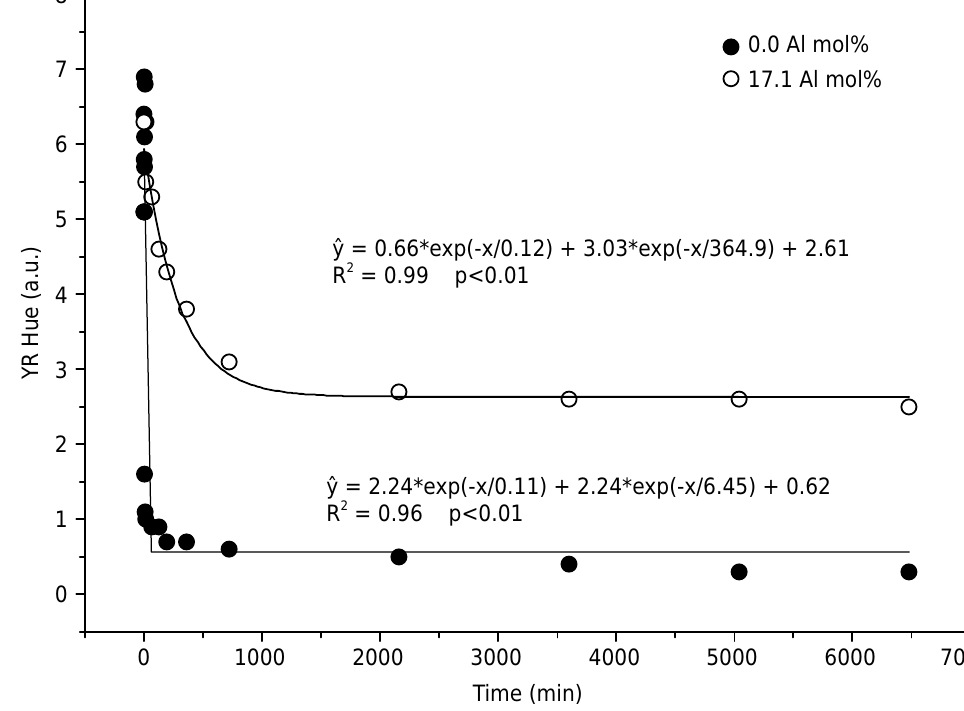
Figure 3. Relationship between YR Hue values of synthetic Al-maghemites transformed into hematites throughout heating period at 500 °C. a.u.: arbitrary